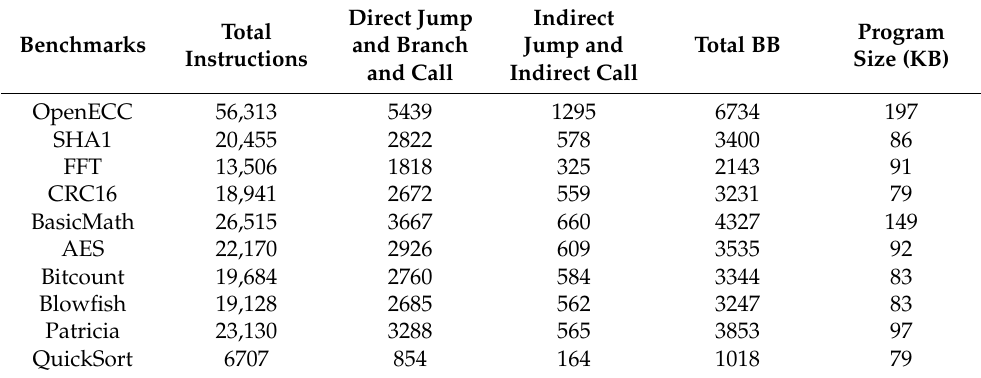
Table 2. Characteristics of the selected